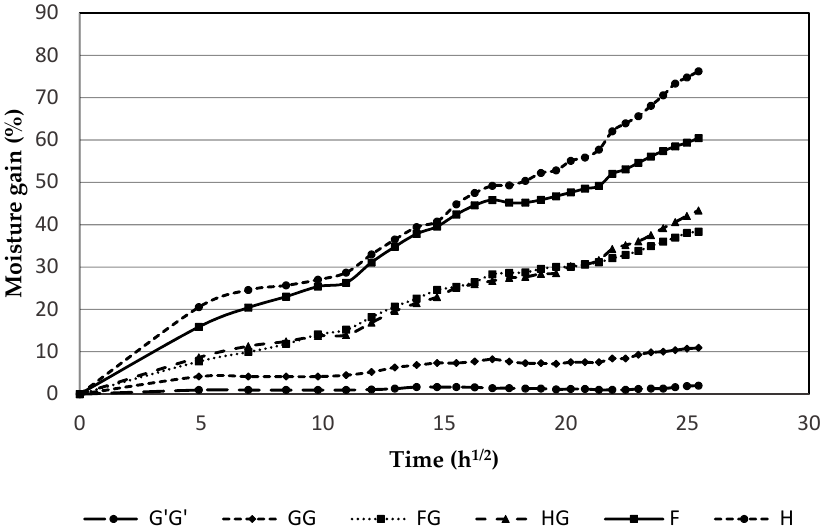
Figure 3. Water absorption of composite samples at room temperature plotted against square root of time for composite samples containing commercial sample with glass fiber (G’G’), glass fiber (GG), flax and glass fiber (FG), hemp and glass fiber (HG), flax alone (F), and hemp alone (H).